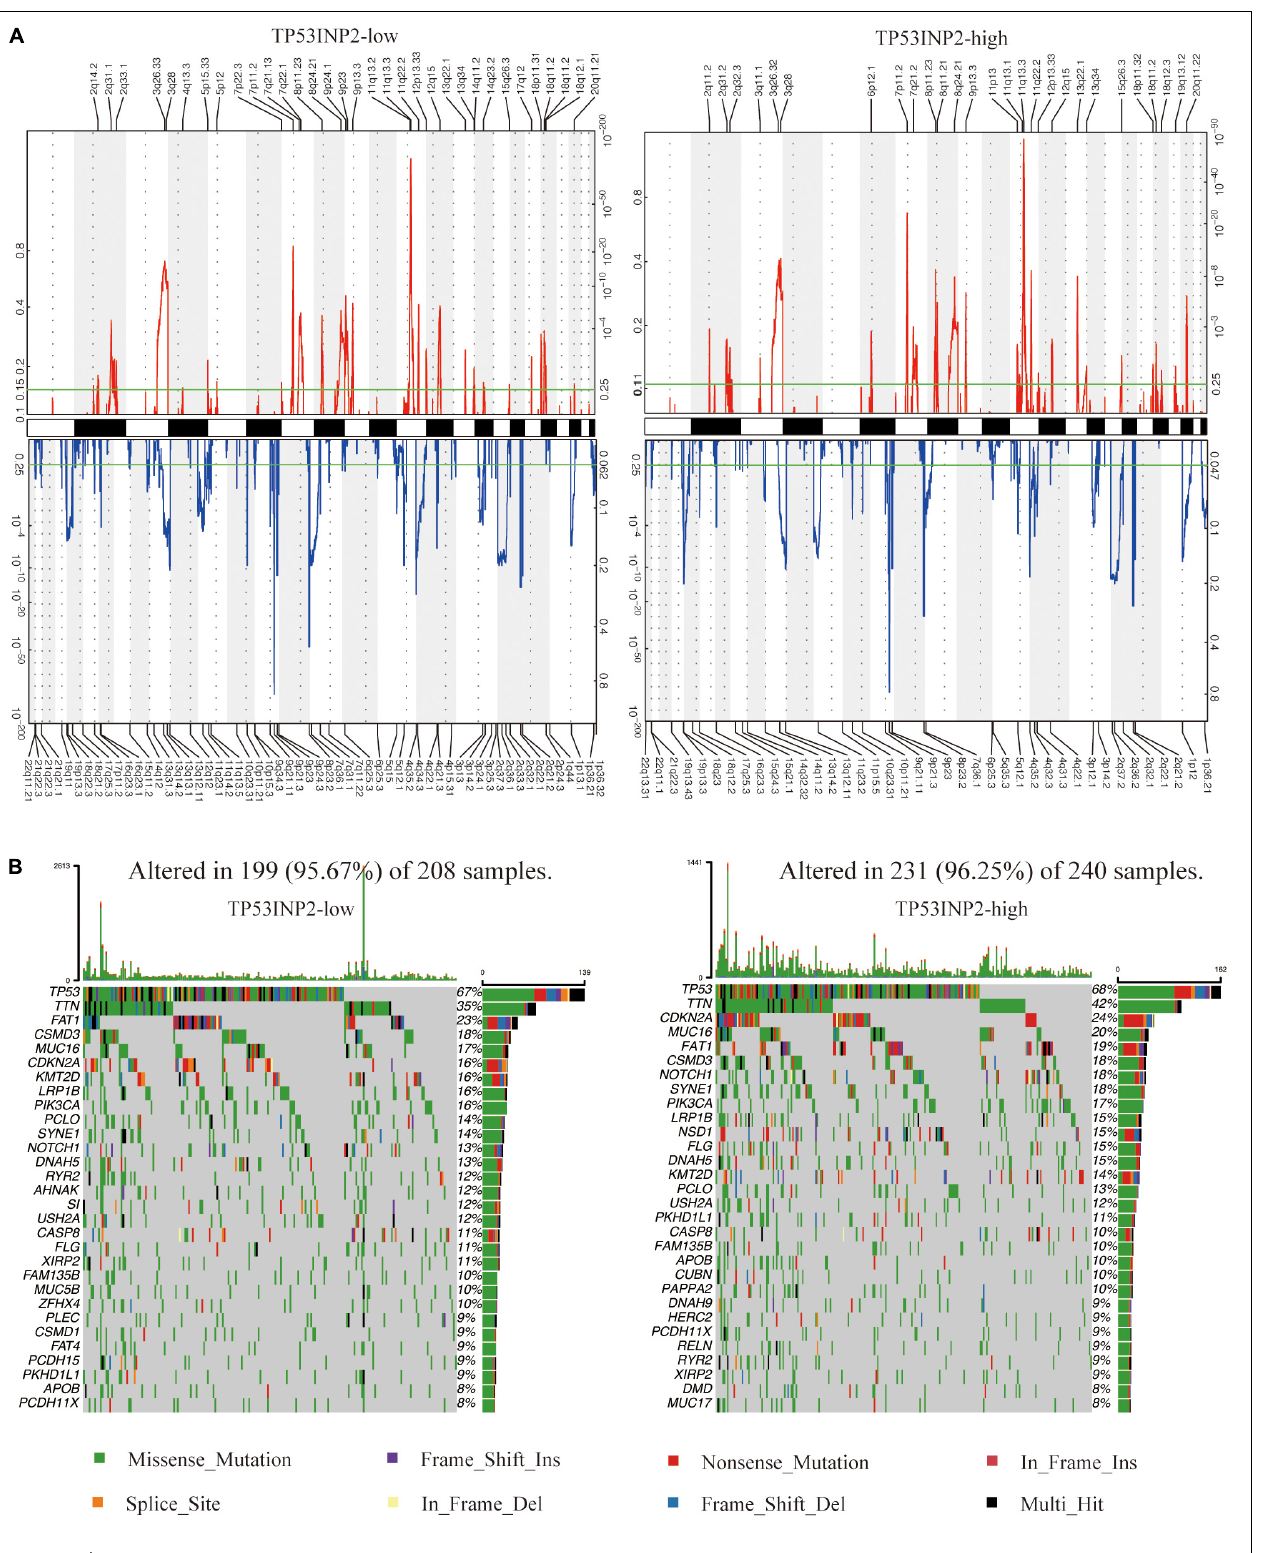
Frontiers in Genetics |